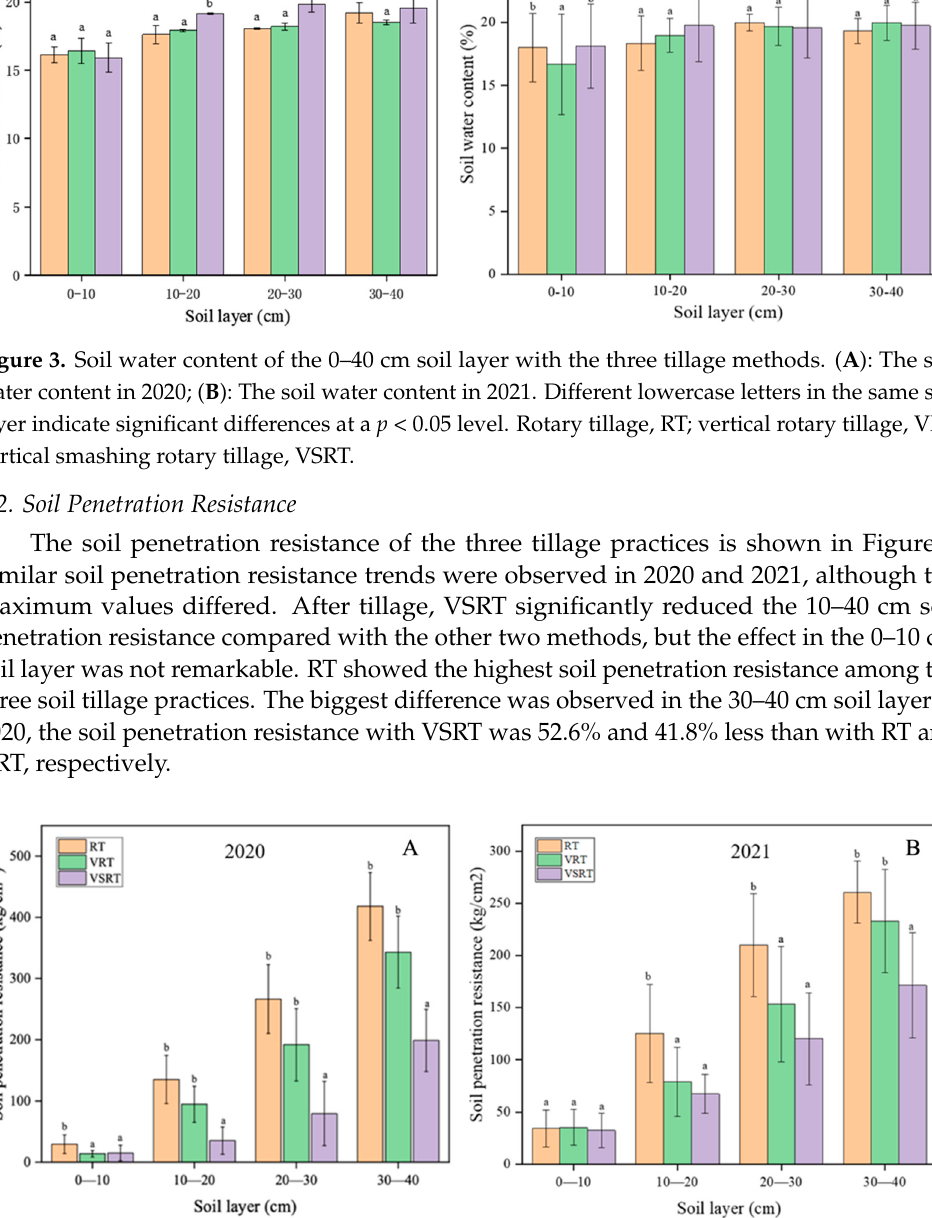
Figure 5. Soil bulk density of the 0—40 cm soil layer under three the tillage methods. ( A ): The soil bulk density in 2020; ( B ): The soil bulk density in 2021. Different lowercase letters in the same soil layer indicate significant differences at a p < 0.05 level. Rotary tillage, RT; vertical rotary tillage, VRT; vertical smashing rotary tillage, VSRT. 3.4. Broccoli Root Growth As shown in Figure 6, in 2020, the root system of broccoli exhibited a rapid growth period within 30 days of planting, and the root length growth rates under the VSRT, RT, and VRT treatments reached the maximum within 10–20 days of planting. In a short time, the root system grew rapidly to about 20 cm. In 2021, the same rapid growth phenomenon